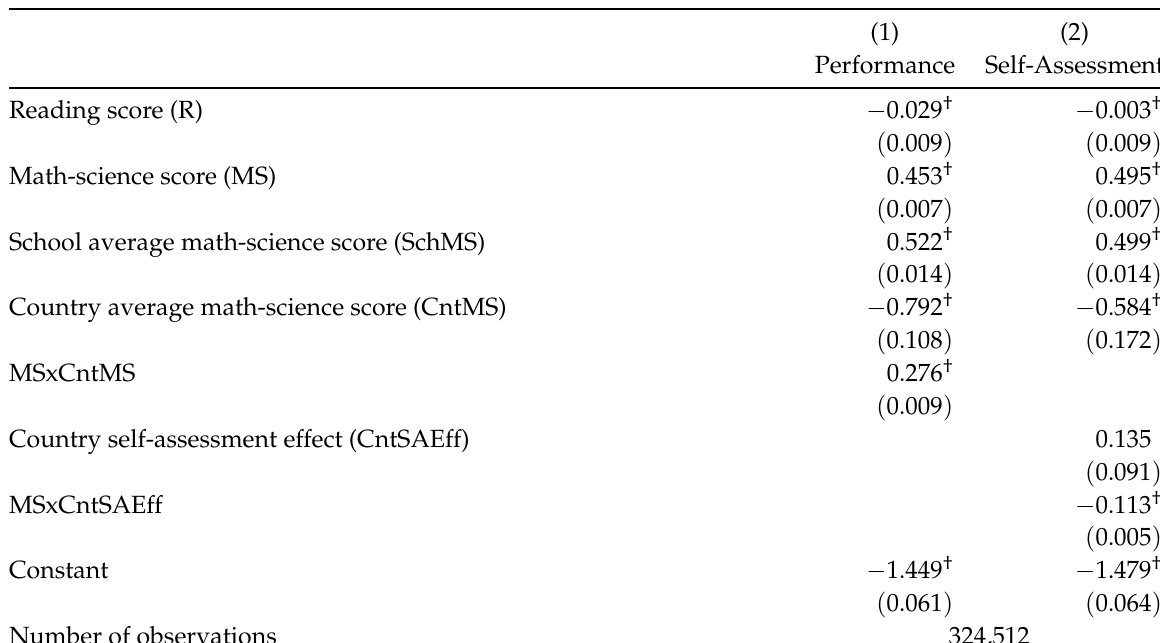
Table 2: Models for STEM Orientation Including Interaction Effects Between the Environment and Individual Math-Science